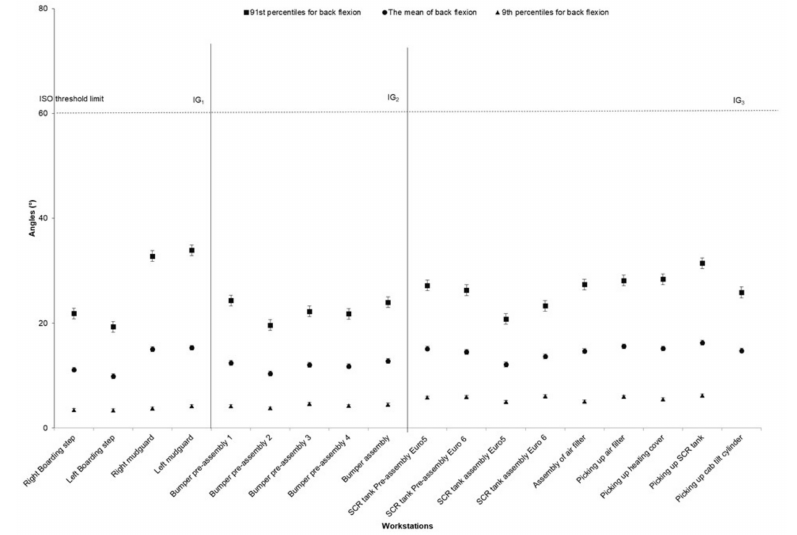
Figure 3. The back angle (the mean, 91st, and 9th percentiles) for di ff erent workstations in the truck assembly plant, (the bars represent standard deviations). The high-risk ISO threshold limit is 60 ◦ for back flexion. Note: IG = Improvement Group; error bars represent standard